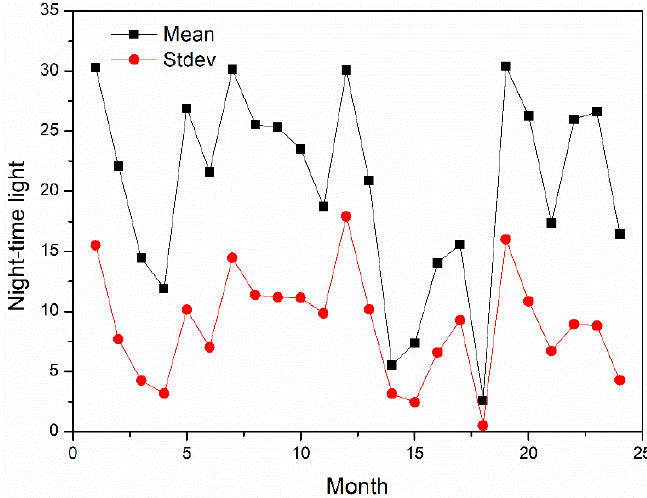
Figure 4. The monthly mean and standard deviation (Stdev) nighttime light values of Yunzhong Industrial Park, Beijiang Province, Vietnam, from January 2019 to December 2020.